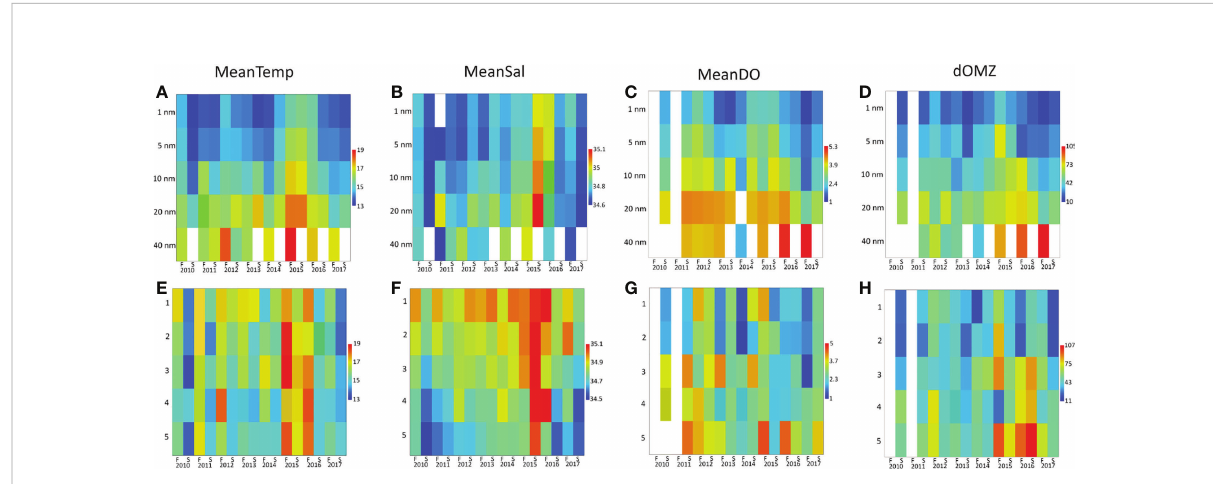
FIGURE 4 Heatmaps of CTD-O derived variables across sampling periods and as a function of distance from the coast (A – D) and latitudinal group (E – H) . F, fall survey; S, spring